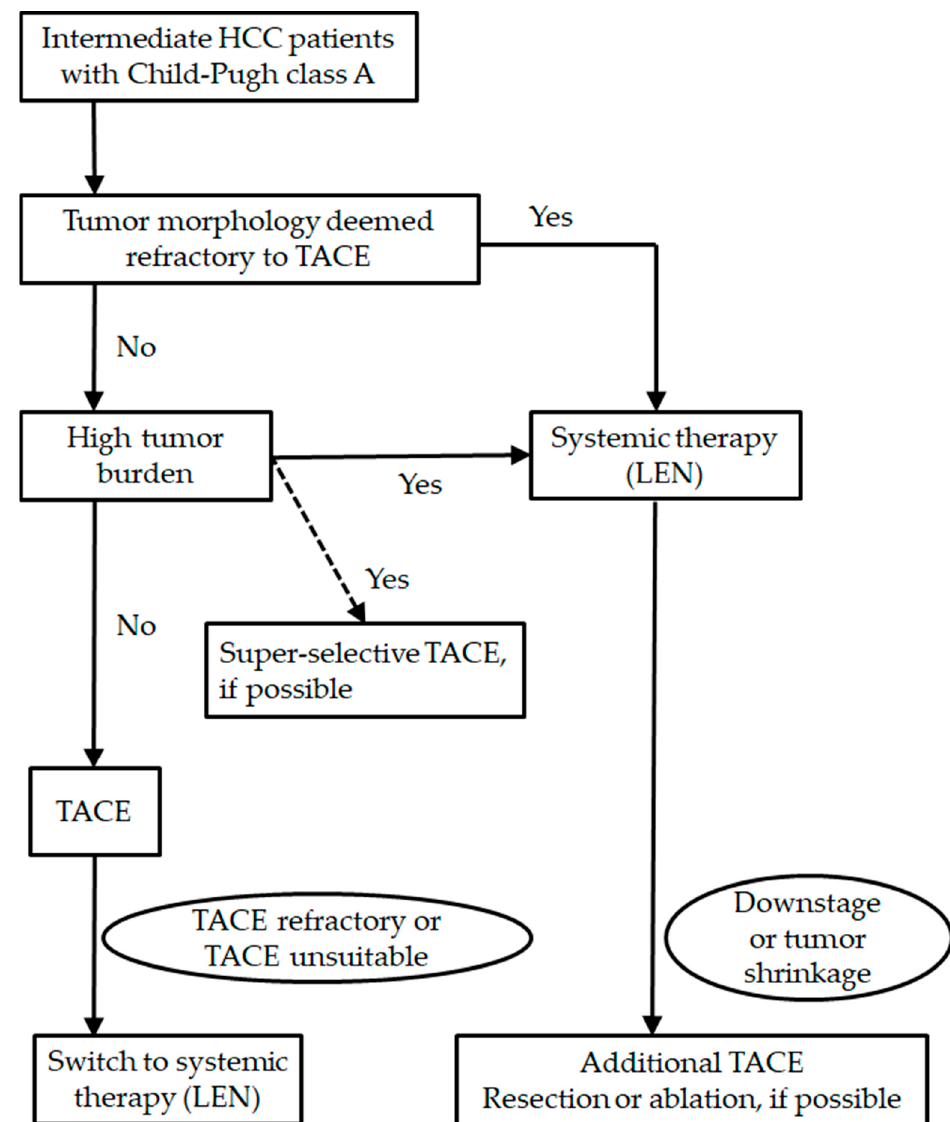
Figure 1. Treatment strategy for Barcelona Clinic Liver Cancer (BCLC) intermediate stage.